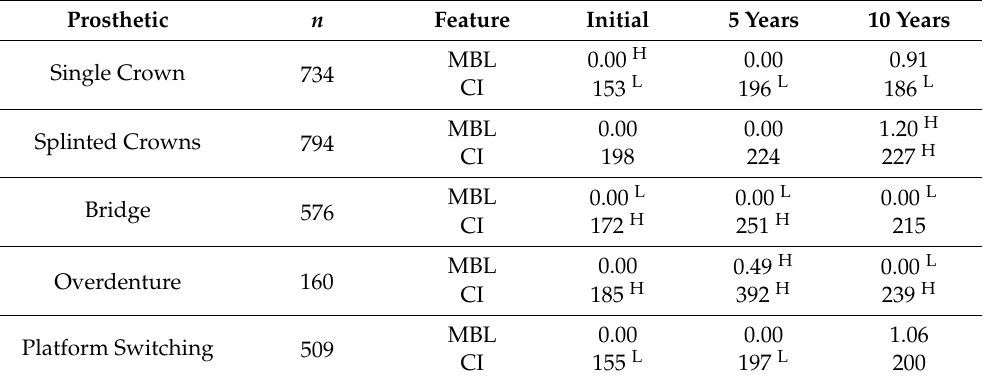
Table 5. The prosthetic works examined in this